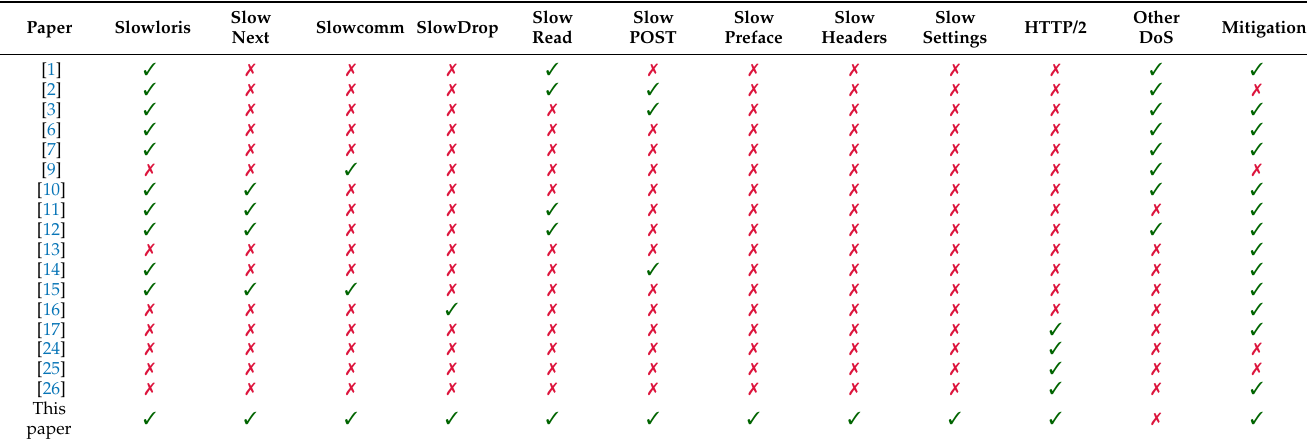
Table 1. Selected papers’